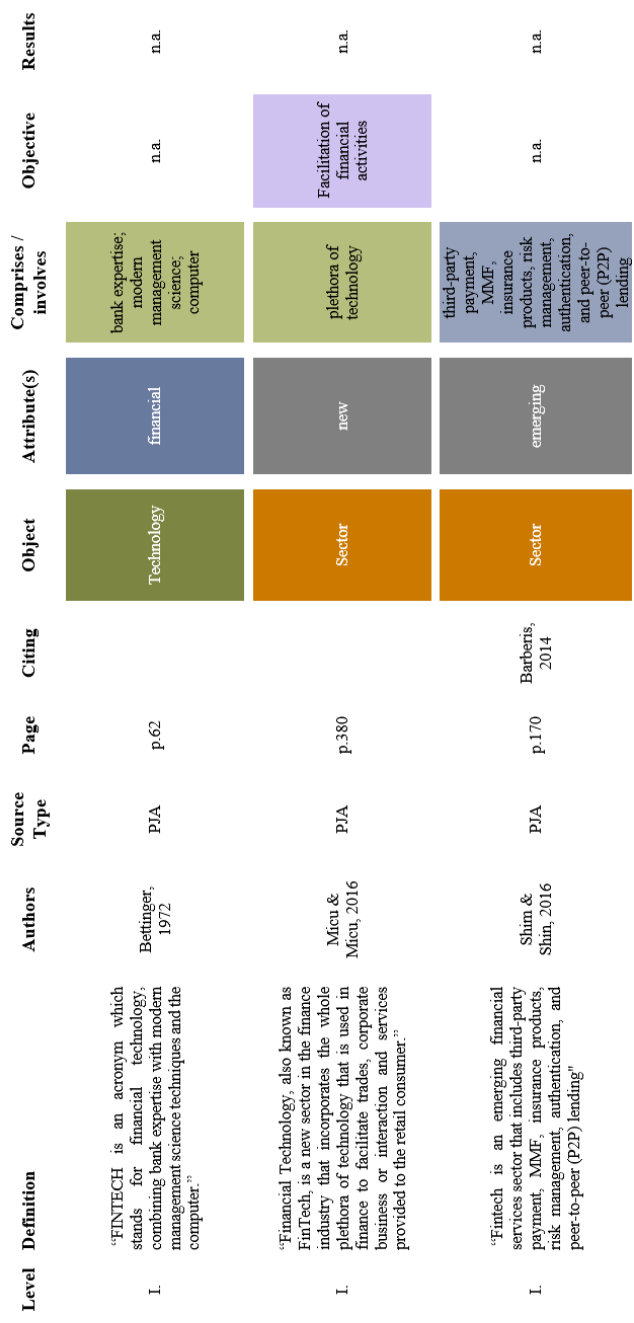
Table 2. Definitions of term fintech, sources, and semantic